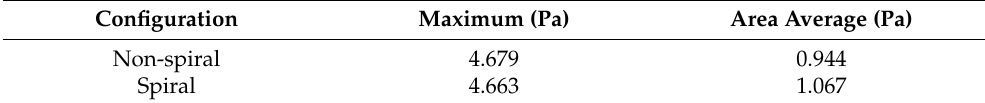
Table 3. TAWSS values according to graft configuration at a 30 ◦ anastomosis angle.